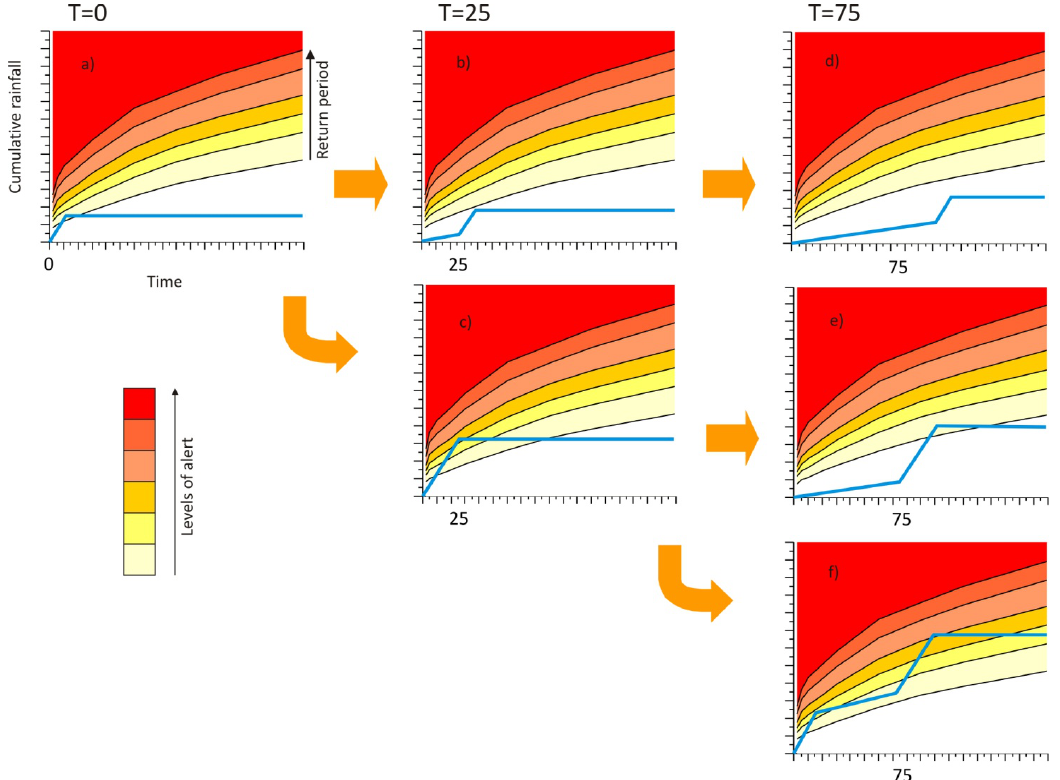
Fig. 15. Conceptual model of the hydrological alert system. Continuous black lines represent DDF curves, color fills show levels of alert, and the blue line indicate cumulative rainfall calculated backward from T =